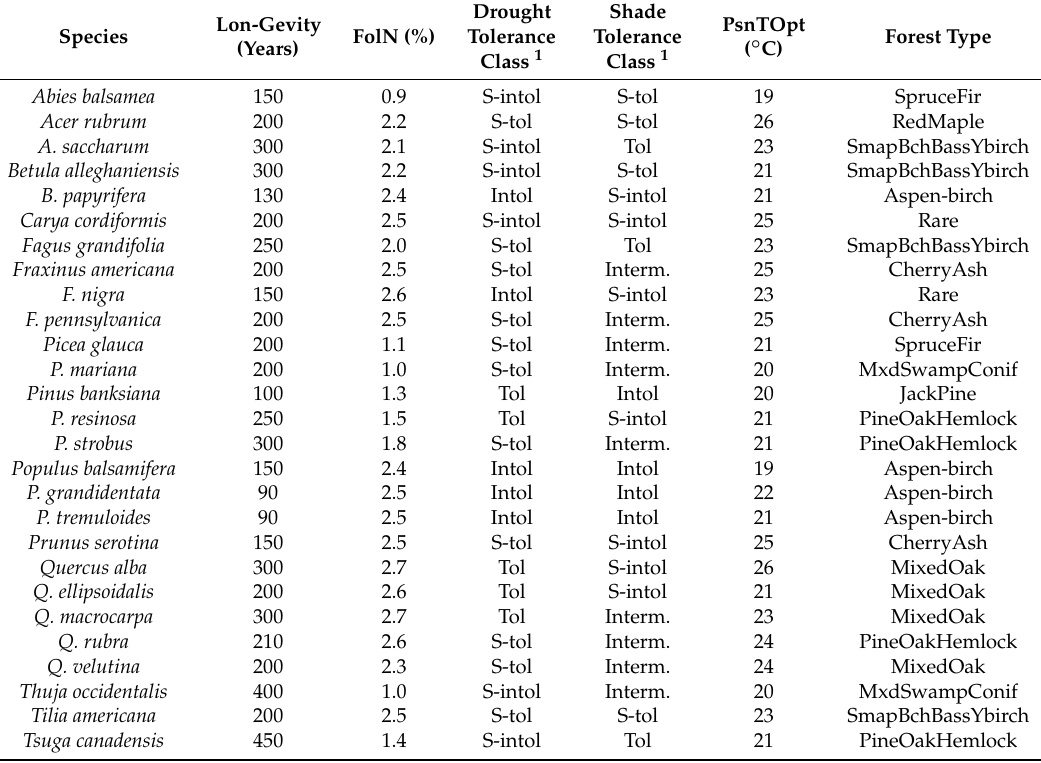
Table 3. Selected life history attributes of species used in the landscape experiment.